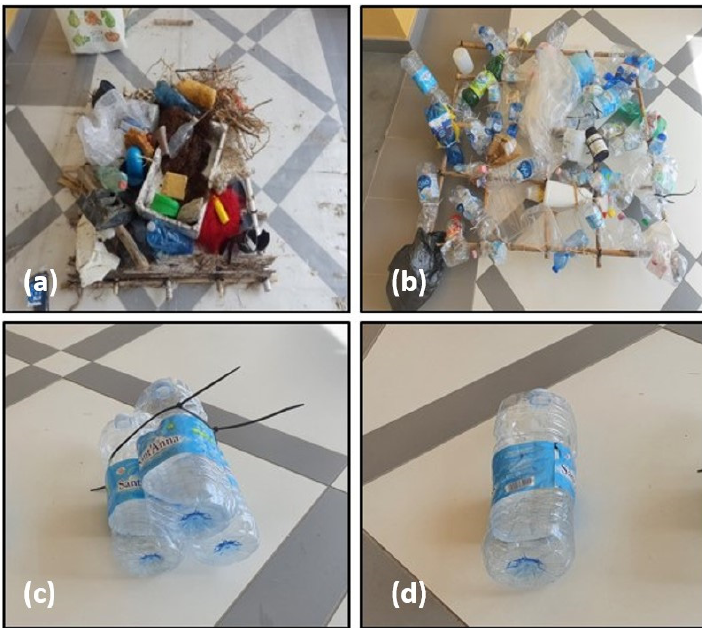
Figure 5. Set of modules used as targets in the measurement campaign. ( a ) Target T0; ( b ) Target T1; ( c ) Target T2; ( d ) Target T3.